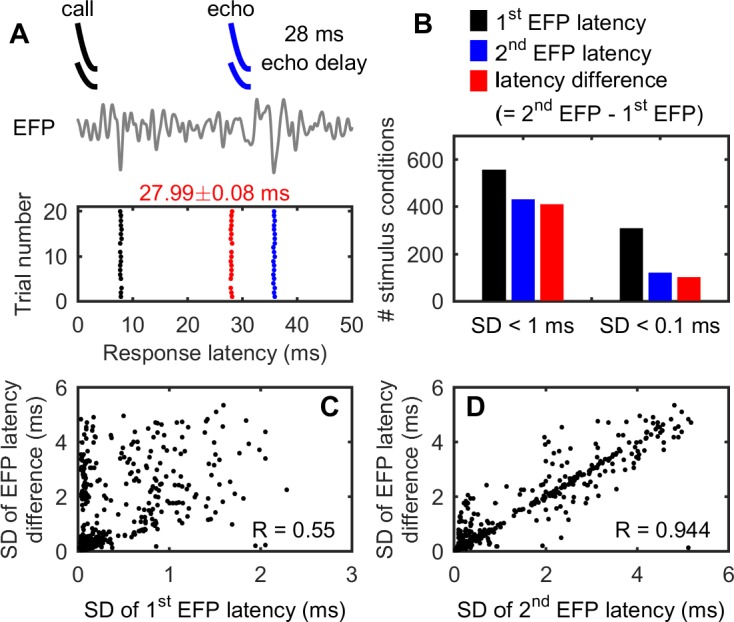
Precise time difference estimation of simulated call–echo pairs by EFP (200–600 Hz).(A) An example of the EFP waveform (gray in color) and raster display of the EFP latencies over 20 times of presentation of a simulated call–echo pair. The “call” was 3 ms in duration and was presented at an amplitude of 75-dB SPL. The “echo” was a 10-dB attenuated copy of the “call” and was presented 28 ms after the call. There were often two EFPs after each presentation (first responses, black dots; second responses, blue dots). The latency difference between the second response and the first response was calculated and displayed as red dots. (B) Relative abundance of the first EFP latency, second EFP latency, and the latency difference between these two. Data were based on a 90% detection reliability, and the total number of tested stimulus conditions was 684 from three bats. Thus, the latency difference estimated by the EFPs reached a submillisecond precision for 411 tested stimulus conditions (60%) and a precision higher than 100 μs for 103 tested stimulus conditions (15%). A stimulus condition refers to EFPs recorded at a particular recording depth for a particular stimulus type, e.g., a call–echo pair of 28-ms echo delay for a recording depth of 1,340 μm, as shown in panel A. The precision of the EFP latency difference was not determined by the precision of the first EFP latency (C) but by the precision of the second EFP latency (D). Data for this figure are included in S1 Data. EFP, extracellular field potential.